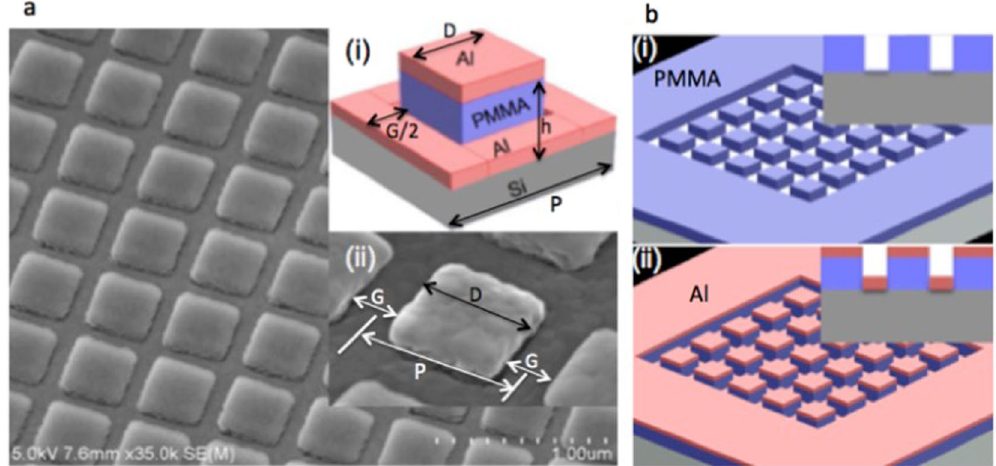
Figure 1. SEM image of the plasmonic pixels in the 2D array structure and its simple fabrication process steps. ( a ) SEM image of the Al square patches hovering on PMMA nano pillars periodically arranged in a square lattice in the background of a fishnet like Al back reflector, insets (i) shows the schematic rendering of a single plasmonic color element and (ii) the slightly tilted (tilt angle of 20°) close-up SEM image of the single colour element. ( b ) Simple fabrication process involving (i) the patterning of 150 nm thick PMMA resist spin coated onto a piece of (100) silicon wafer using EBL. The exposed area of the resist is removed in a developer solution leaving PMMA nano pillars (inset shows the cross-sectional view). (ii) A 45 nm thick aluminum thin film is thermally evaporated onto the nano pillars for realizing vivid full colour